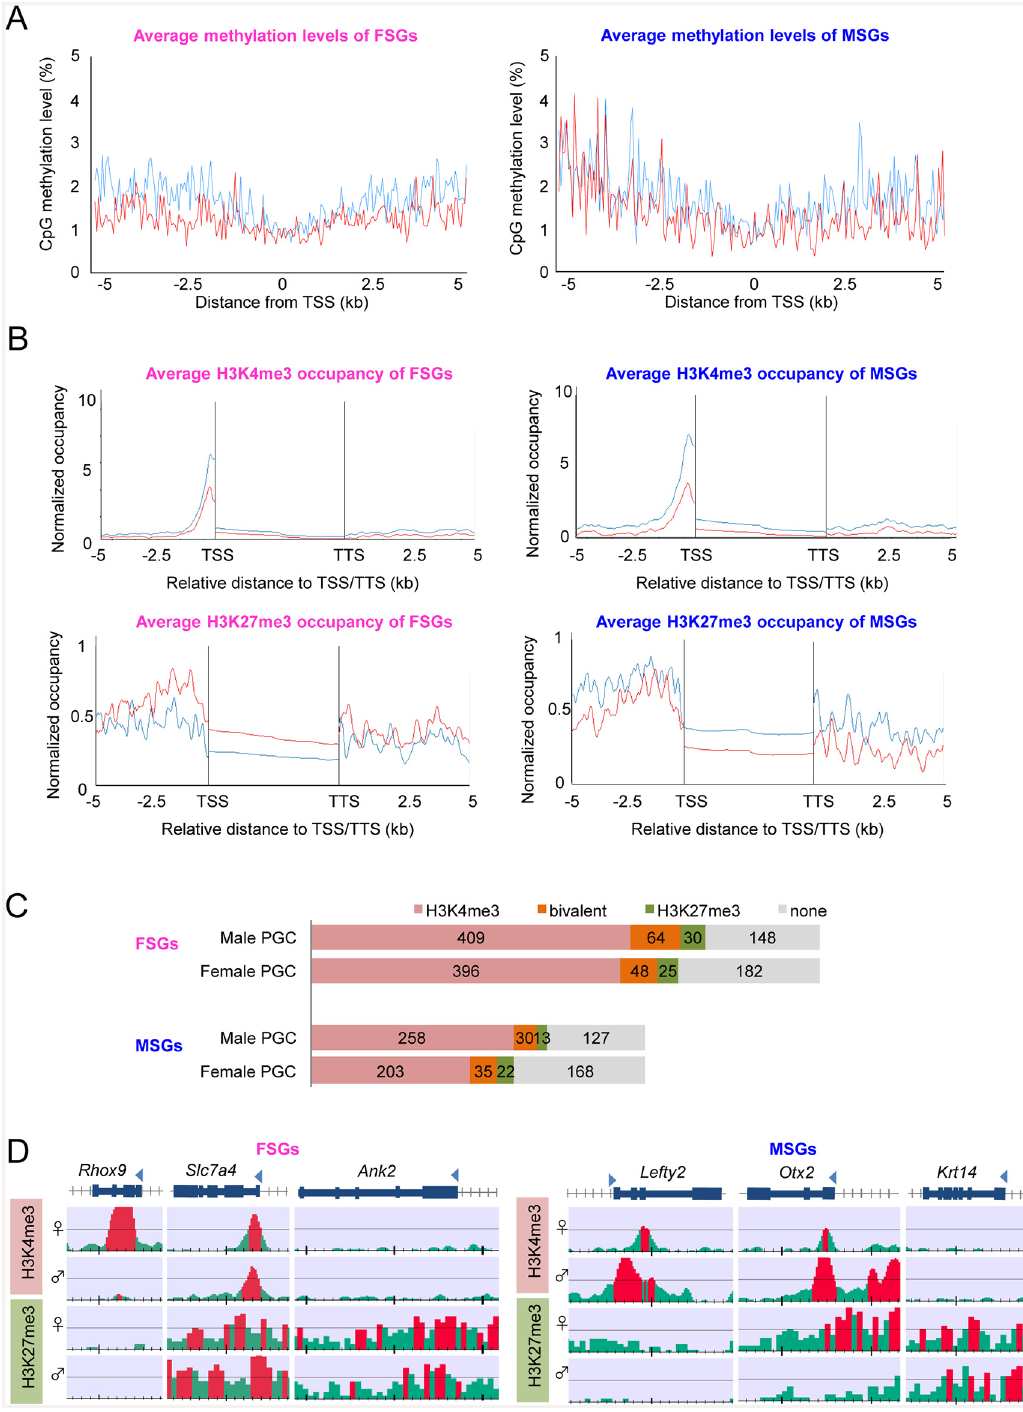
Fig 4. DNA methylation and histone modifications in female- and male-specific PGC-expressed genes. (A) Average methylation levels of TSS and the shore values ( ± 5 kb of the TSS) in female- and male-specific PGC-expressed genes. Our previous methylation data of PGCs were obtained from the DDBJ database [ 12]. (B) Occupancy of H3K4me3- and H3K27me3-bound TSS and TTS shore regions ( ± 5 kb of the TSS and TTS) in female- and male-specific PGC-expressed genes. (C) Proportion of genes showing histone-modification patterns. The number of genes classified into each histone-modification pattern is shown. (D) Three typical histone-modification patterns. The red regions indicate ChIP/input enrichment-peak regions that were calculated using the DROMPA peak-calling program.